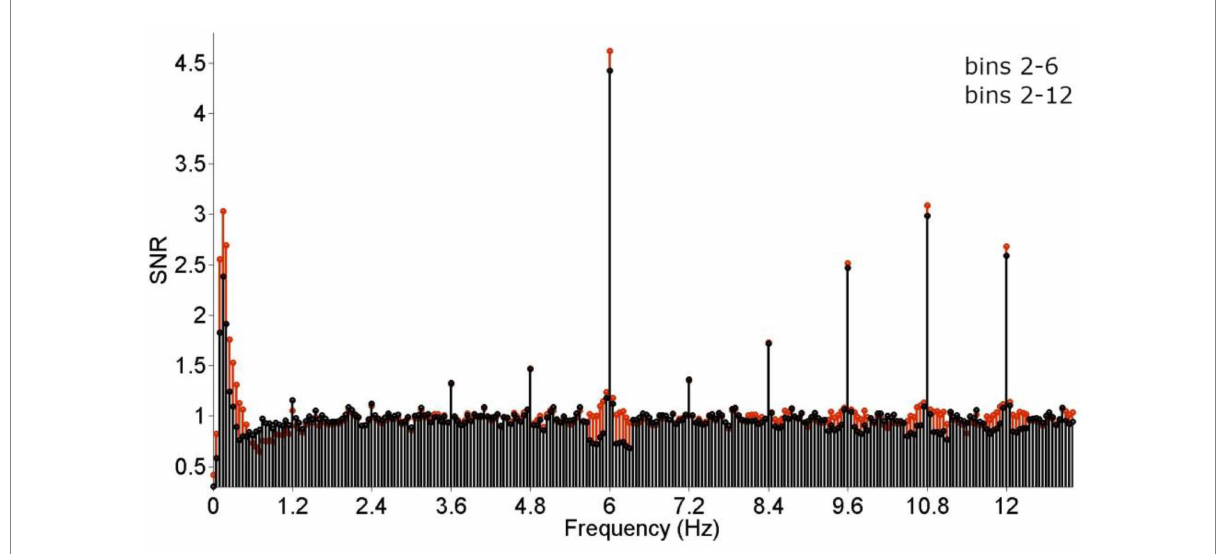
FIGURE 3 Grand-average frequency-spectrum responses. Base (6 + 12 Hz) and categorization (1.2, 2.4, 3.6… 10.8 Hz) responses are clearly visible and highly significant. The effect of the number of bins employed for baseline correction was evaluated by comparing signal-to-noise-ratios (SNRs) was compared across 10 (2–6) and 20 (2–12) bins. While employing a larger number of bins did not seem to affect responses at higher frequencies (from 6 Hz onwards) detrimentally, response strength was stronger when employing fewer bins at lower frequencies (below 6 Hz). Crucially, the effect seemed strongest at 1.2 Hz, corresponding to the stimulation